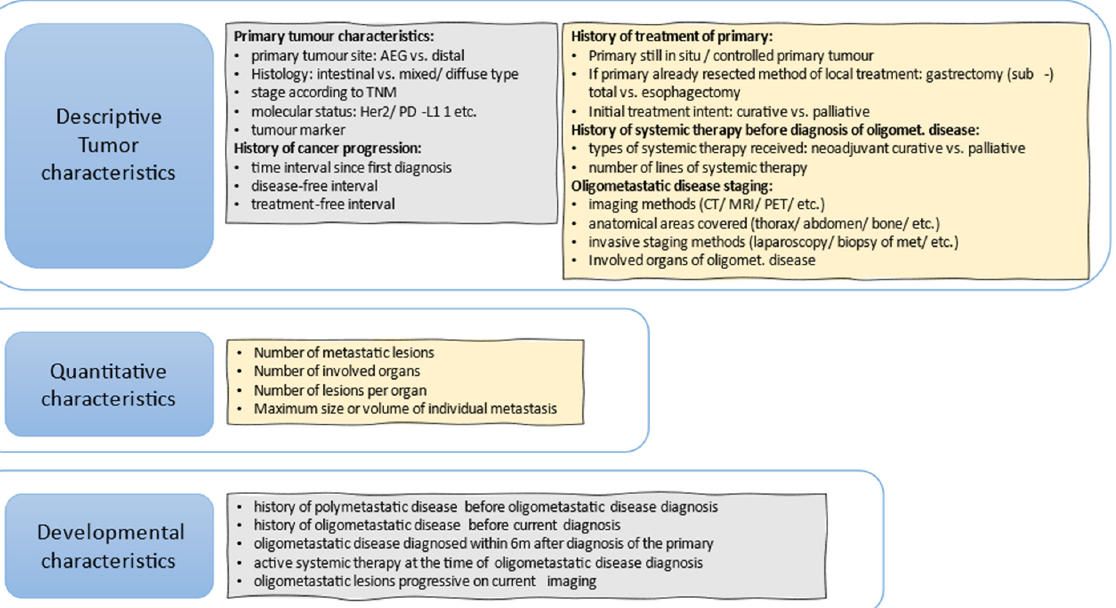
Figure 1. Useful questions to further define OMD, based, with modifications, on (Guckenberger et al., 2020) [18]. 2. Trials in Oligometastatic Esophagogastric Cancer A pilot of the German Gastric Group (FLOT study group) [22] established a clinical model to identify and harmonize characteristics of patients that could potentially benefit from surgical intervention in their metastatic gastric cancer disease after an initial induc ‐ tion systemic chemotherapy. One of the best evaluations currently available for defining OMD in gastric and esophagogastric junction (GEJ) adenocarcinomas, supported by com ‐ paratively sufficient study data, is based on the results of the German prospective multi ‐ center FLOT ‐ 3 trial [22], which is also used in the resulting German follow ‐ up multicenter randomized FLOT ‐ 5/RENAISSANCE trial [18,23] and in the German S3 Guidelines [24]. In the FLOT ‐ 3 trial [22] of the German Gastric Group, therapy ‐ naïve patients with gastric or GEJ adenocarcinoma were stratified into three groups (A–C): (A) clearly resec ‐ table without evidence of systemic disease, (B) limited metastatic, and (C) patients with diffuse metastatic disease, using a previously determined algorithm and using FLOT as the standard regimen. The limited metastatic group included patients with metastatic lymph node involvement at distant intra ‐ abdominal lymph nodes only or/and a maxi ‐ mum of one metastatic organ system affected (with less than five liver metastases if the affected organ was the liver), and with no signs of macroscopically detectable carcinoma ‐ tosis (peritoneum or pleura) and good performance status (ECOG ≤ 1). Metastatic patients